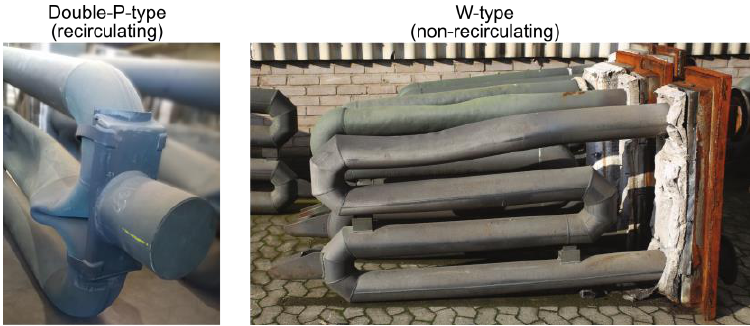
Figure 2. Examples of damaged recirculating and non-recirculating metallic radiant tubes in CGLs. Figure 1. ( a ) Schematic of the annealing furnace of a continuous strip galvanizing line (CGL); ( b ) View from the bottom into the heating section of an annealing furnace.